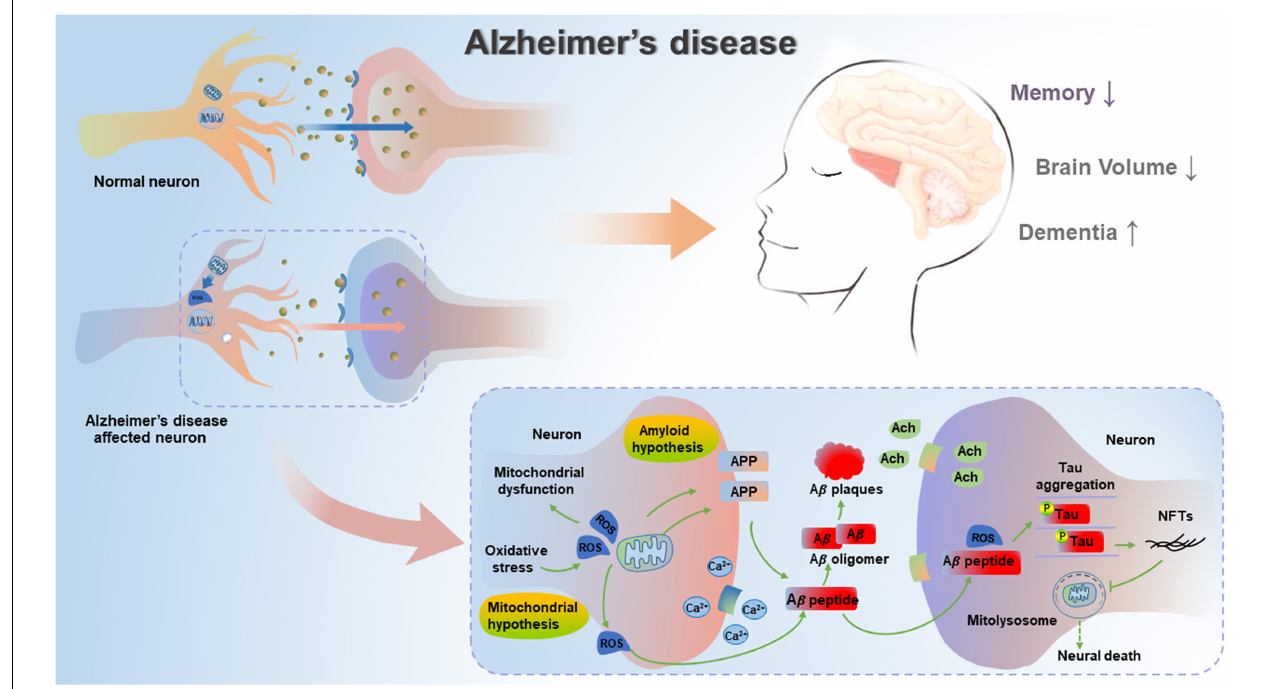
FIGURE 1 | Mitochondrial cascade hypothesis and amyloid cascade hypothesis in AD. In unaffected neurons, healthy mitochondria are distributed through the neuron. In AD-affected neurons, mitochondrial dysfunction causes deficient energy metabolism and increased oxidative stress, thereby leading to increased amyloidogenic process of APP and the aggregation of hyperphosphorylated Tau. Pathogenic A β and hyperphosphorylated Tau can result in impaired mitophagy, subsequent increase in damaged or dysfunctional mitochondria, and blockage in mitolysosome, thereby leading to neural death in